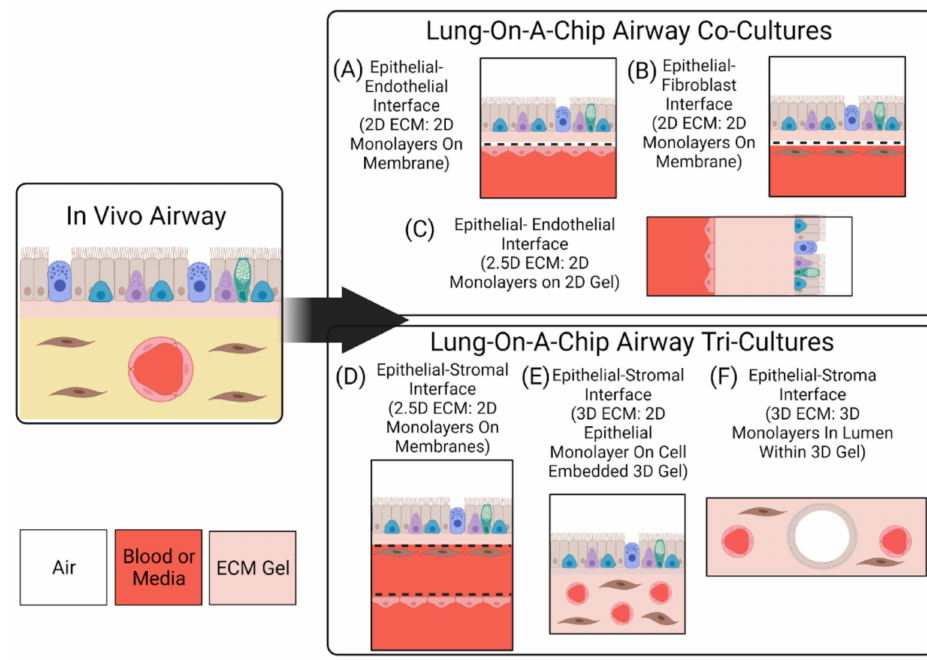
Figure 2. Interfaces and Dimensions of Lung-On-A-Chip Devices. Lung-on-a-chip devices can be made to incorporate monoculture, co-culture, or tri-culture of cells. Here, 2D, 2.5D, and 3D refer to the organization of the cell layers on the supporting scaffolds. Monocultures (not shown) would comprise only the epithelial layer as in ( A ). ( A ) Epithelial cell monolayer on the apical side of a permeable membrane, with endothelial cell monolayer on the basal side of the membrane. ( B ) Epithelial cell monolayer on the apical side of a permeable membrane, with fibroblast cell monolayer on the basal side of the membrane. In ( A , B ), the monolayers are stacked vertically, i.e., parallel to the objective lens’s optical axis in microscopy. ( C ) The epithelial and endothelial cell monolayers are cultured on a hydrogel, and the layers are stacked perpendicular to the objective lens’s optical axis in microscopy. ( D ) The tri-culture features two permeable membranes, separating the stromal cells from the endothelial cells. ( E ) The tri-culture comprises an epithelial cell monolayer on top (apical side) of a 3D gel, inside which the stromal cells and vascular endothelium are embedded. ( F ) The tri-culture comprises cell-lined lumens within a 3D gel embedded with stromal cells. The epithelial cells form a single cell layer lining an air-filled lumen, while the endothelial cells form a single cell layer lining a blood/media-filled